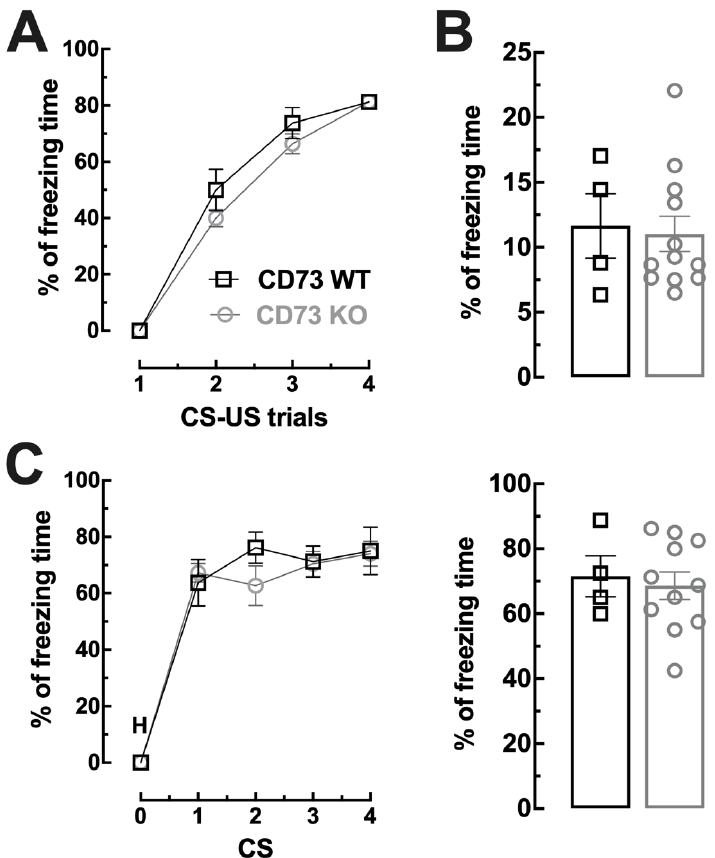
Figure 4. The genetic deletion of CD73 did not modify fear learning and memory. ( A ) Fear condi- tioning of CD73 KO mice and WT littermates. The learning curve of cued fear conditioning was similar between CD73 KO mice and WT littermates; both groups of mice displayed increased freezing behavior at each CS–US trial, showing a normal acquisition of fear. ( B ) Contextual fear memory: 1 day after fear conditioning, CD73 KO mice and WT littermates were re-exposed to the conditioning chamber (context A) in the absence of the US and displayed similar freezing behavior. ( C ) Cued fear memory: CD73 KO mice and WT littermates had similar freezing behavior upon presentation of the CS (a tone of 80 dB presented during 20 s; 4 trials after 2 min habituation (H) period) in the absence of the US, in a novel context B, 2 days after fear conditioning (graph on the left ) and an overall equal percentage of freezing throughout the experiment (graph on the right ). The values are mean ± SEM of n = 7–9